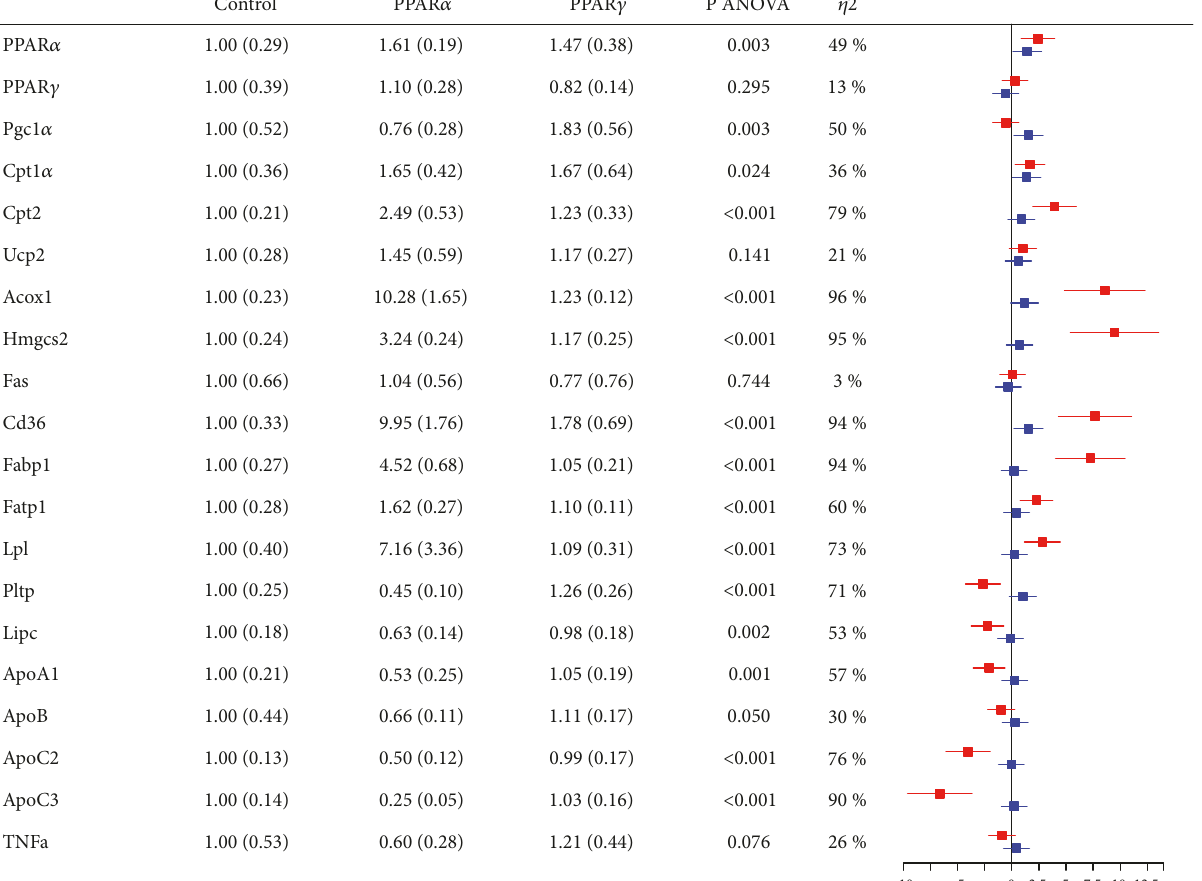
3-hydroxy-3-methylglutaryl-CoA synthase 2 ( Hmgcs2 )